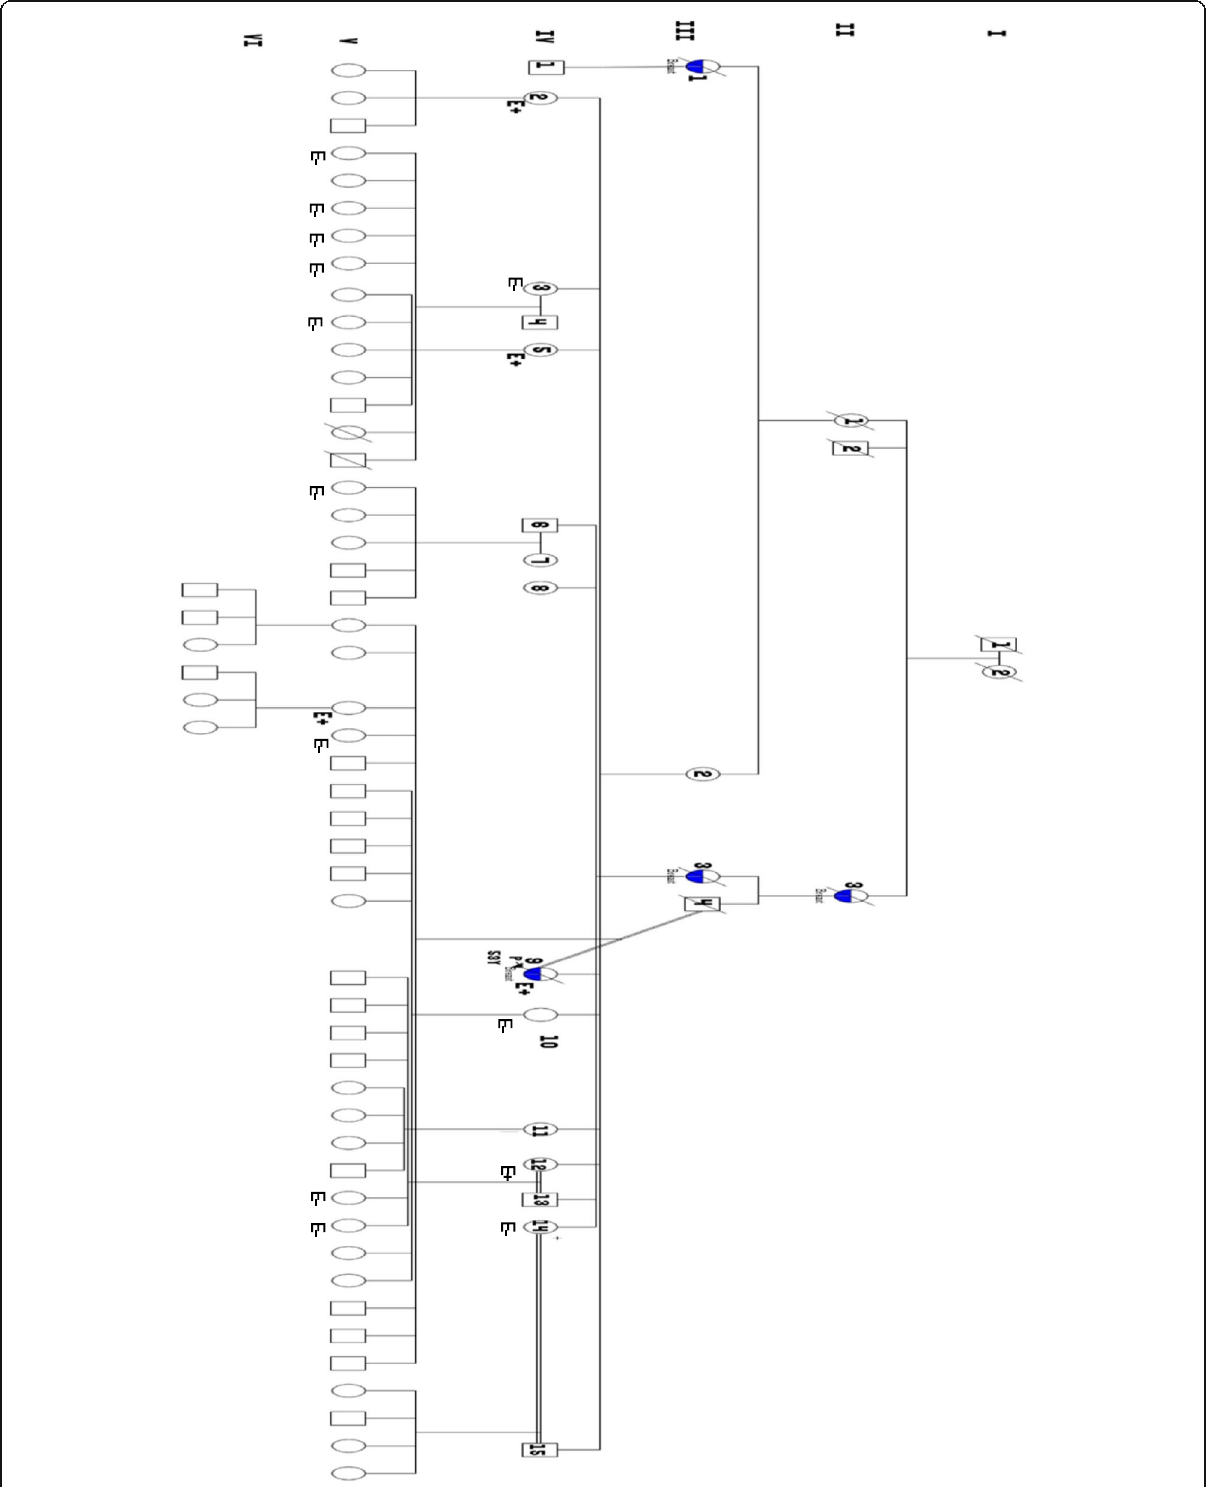
Fig. 1 Pedigree and pathogenic variant status of recruited family